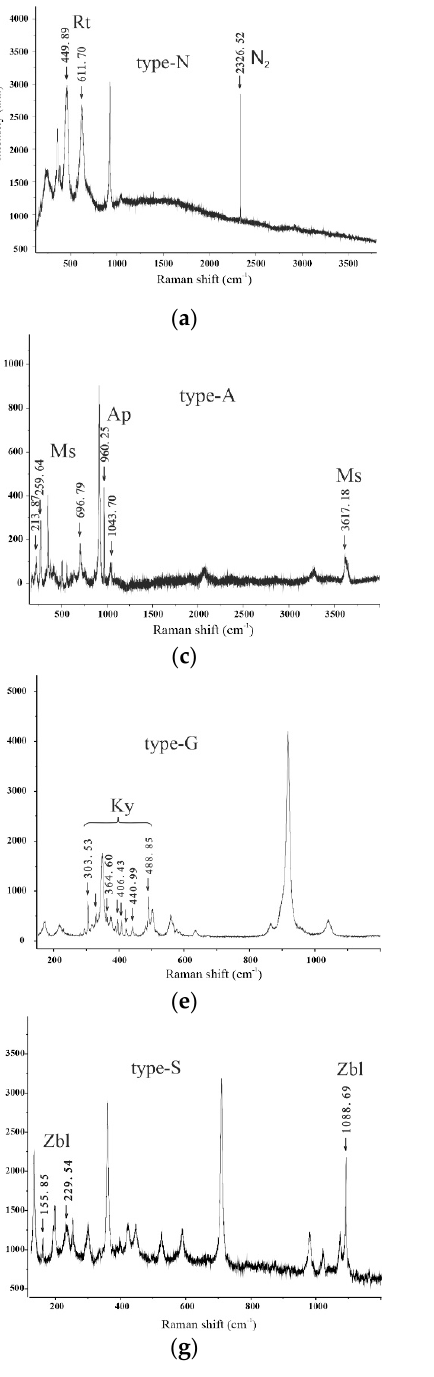
Figure 4. Raman spectra of selected FI-types. Peaks without numbers are related to the host minerals garnet ( a – e ), tourmaline ( f ), spodumene ( g ), and quartz ( h ). ( a ) Type-N inclusions characterized by a dominant N 2 (2326.52 cm − 1 ) peak. Spectra with numbered peaks correspond to rutile as an enclosed mineral phase. ( b ) Type-N inclusion containing rhodochrosite as solid-phase inclusion. ( c ) Type-A inclusion containing apatite and muscovite solid phases. ( d ) Type-G inclusion consisting of CO 2 (1281.10 and 1385.84 cm − 1 ) and N 2 (2328.76 cm − 1 ). ( e ) Type-G inclusion containing a kyanite solid phase. ( f ) Spectra of type-T1 inclusion in tourmaline consisting of CO 2 (1284.47 and 1388.86 cm − 1 ) and N 2 (2329.95 cm − 1 ). ( g ) Type-S inclusion in spodumene containing a zabuyelite solid phase. ( h ) Spectra of type-Q1 inclusion consisting of CO 2 (1282.91 and 1387.10 cm − 1 ) and N 2 (2326.82 cm − 1 ).